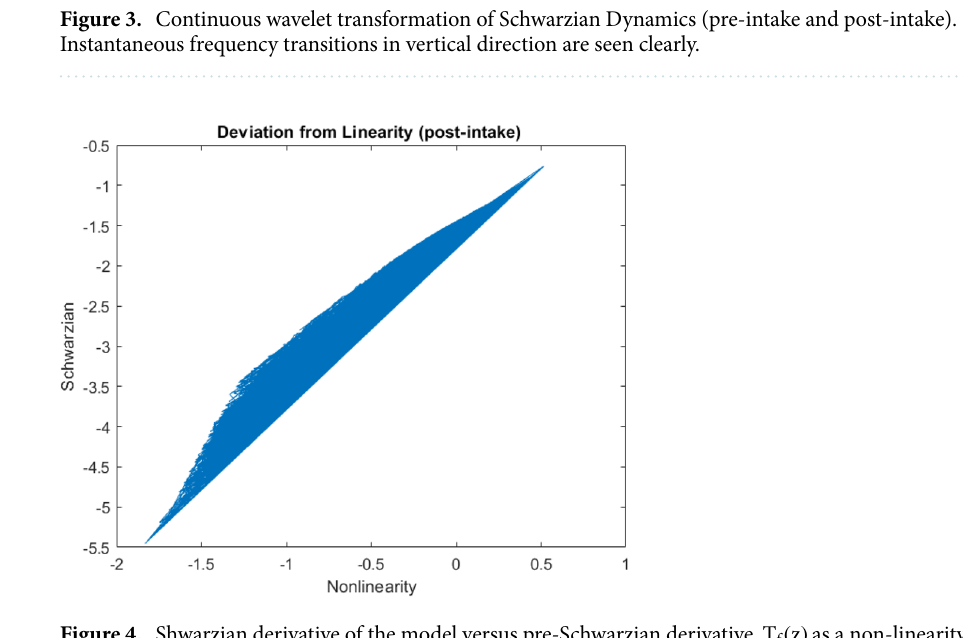
Figure 4. Shwarzian derivative of the model versus pre-Schwarzian derivative, T f ( z ) as a non-linearity post- intake term (the slope of the linearity (gain) is higher and Schwarzian negativity is